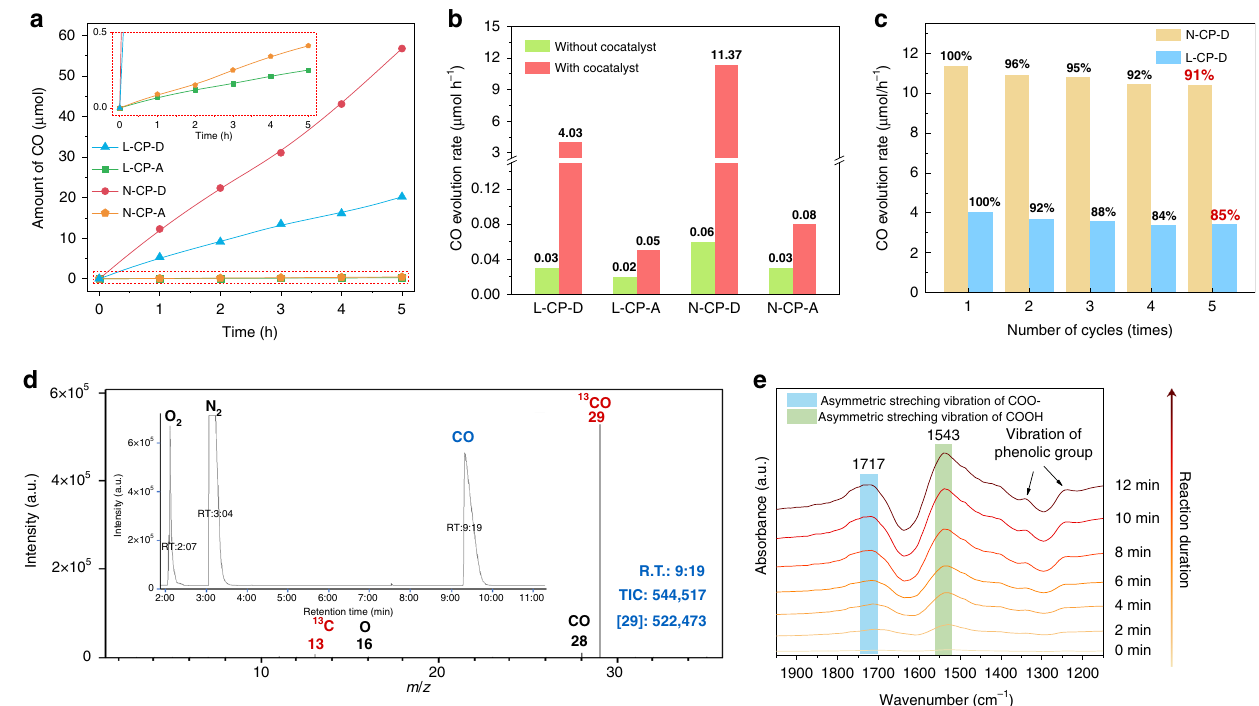
Fig. 3 CO 2 photoreduction performance of the CPs. a Time course of the produced CO for CPs during 5 h experiment performed under visible light (420 nm cut-off fi lter) in an acetonitrile/water (7:3) mixture using triethanolamine (TEOA) as sacri fi cial agent and 5 μ mol Co (II) bipyridine complexes as a cocatalyst over 5 mg CPs under ~80 KPa of pure CO 2 gas, inset: X -axis enlarged performance of CO evolution. b Average CO evolution rates for CPs with (red bar) or without (green bar) cocatalyst, c Recyclability of N-CPD (yellow bar) and L-CP-D (blue bar) in the photocatalytic CO 2 reduction within fi ve cycles. d Mass spectra of 13 CO and total ion chromatography (inset) over N-CP-D in the photocatalytic reduction of 13 CO 2 . e In-situ diffuse re fl ectance infrared Fourier transform spectroscopy (DRIFTS) for the photocatalytic reduction of CO 2 over